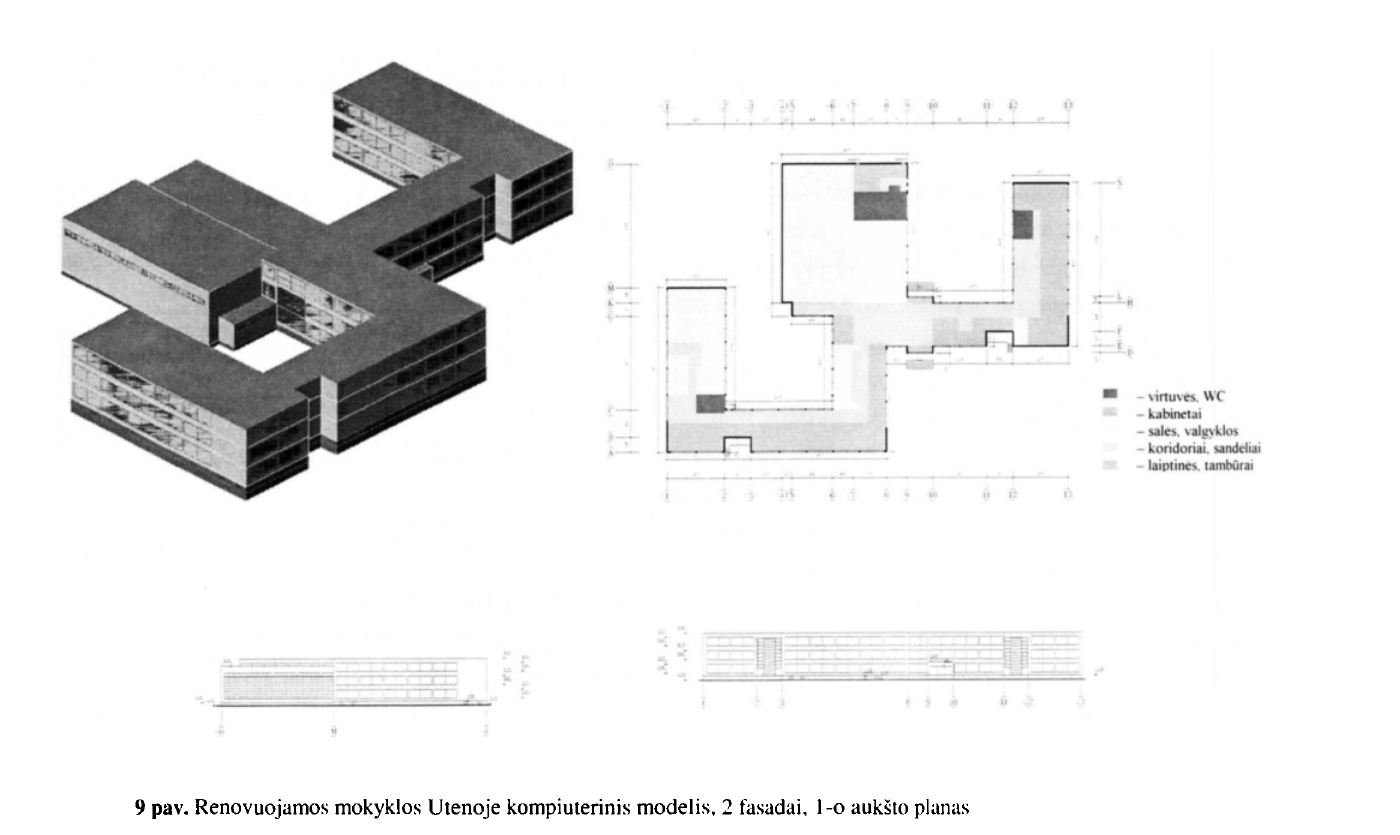
buvo priskirta siluminio rodiklio (silumos perdavimo koeficiento U) reiksme. veliau be kliiiciq automatizuotu biidu buvo analizuojamas metrikos, energetiniu bei eko nominiu atzvilgiu.